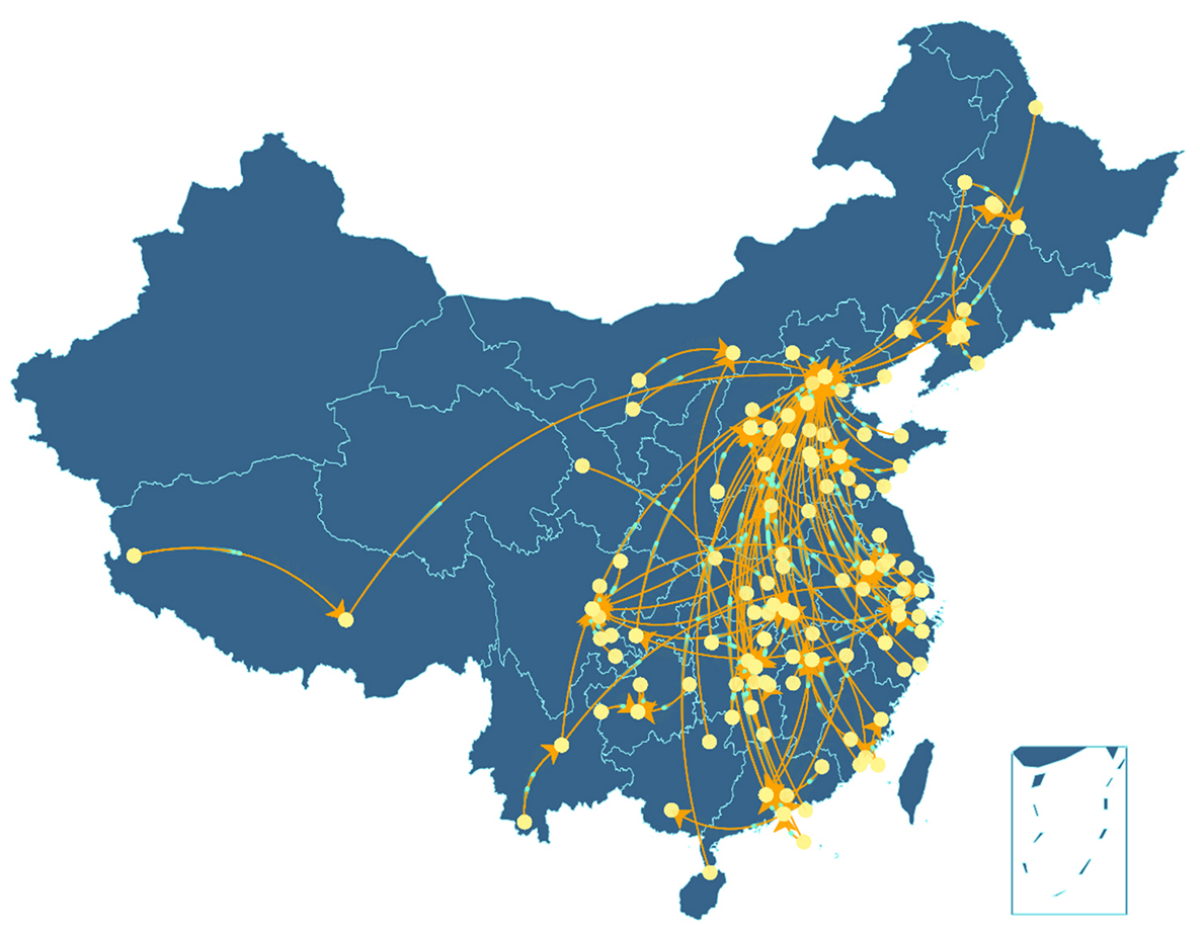
Figure 4. The geographic distributions of rumor sources and refuters during the outbreak of COVID-19 between January 20 and April 8, 2020, in